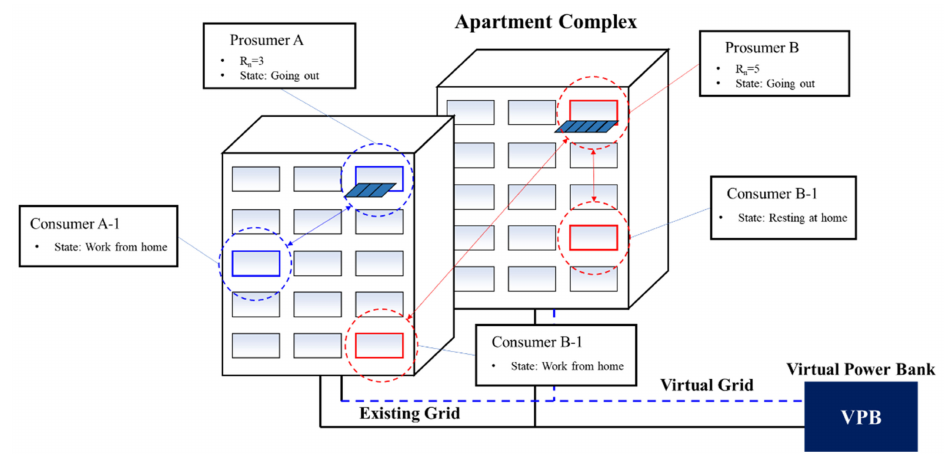
Figure 7. Small-scale energy trading model in an apartment complex.